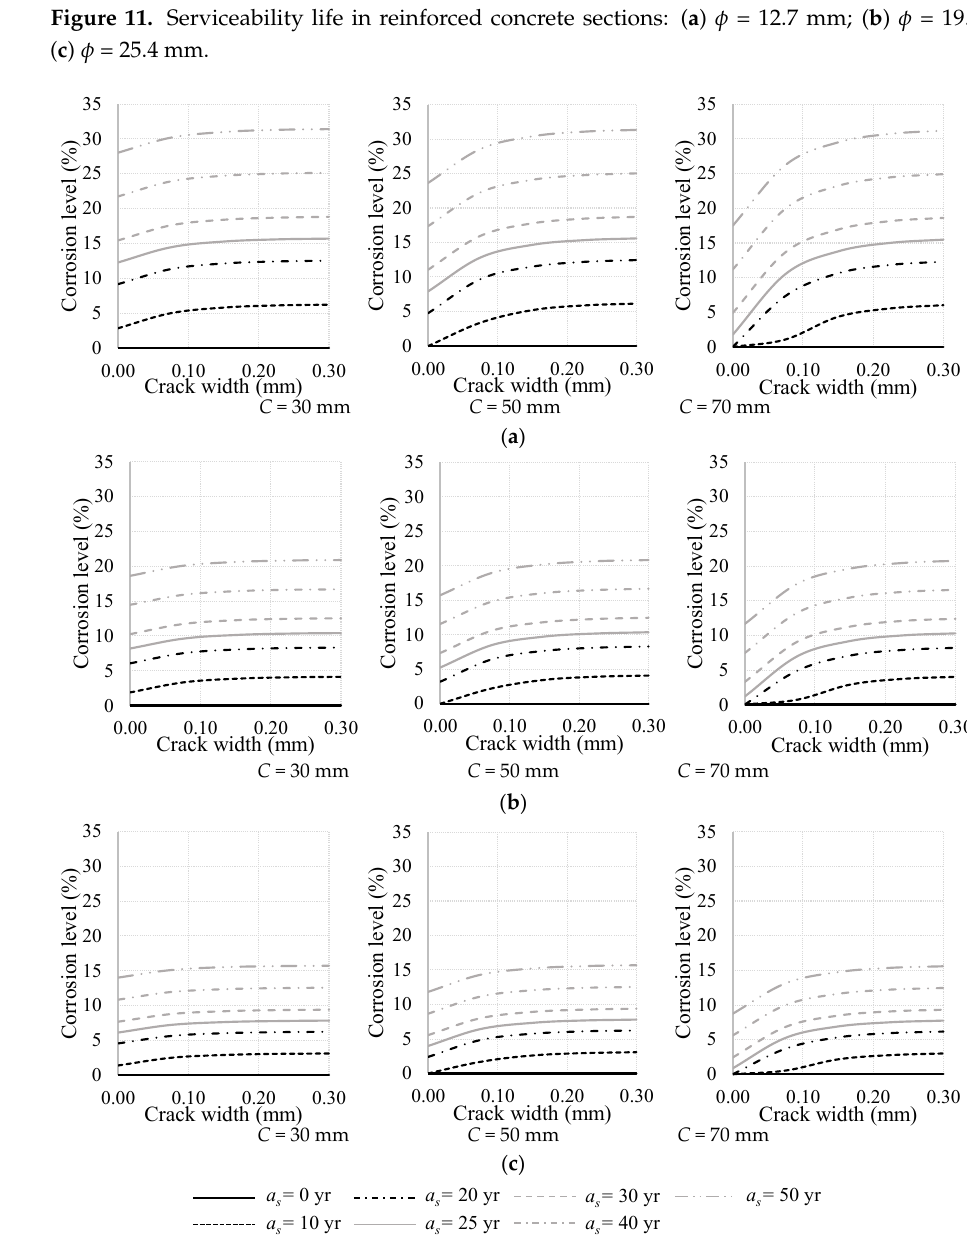
Figure 12. Corrosion level: ( a ) ϕ = 12.7 mm; ( b ) ϕ = 19.1 mm; ( c ) ϕ = 25.4 mm. The initiation time depends on the concrete cover. Regardless of the width cover, the initiation time is significantly reduced (up to 98%) because of the crack with effect, event within its recommended range. It is due to the initiation time which was significantly re ‐ duced (up to 98%) because of the cracked cover. As a result, the serviceability life can reduce up to 62% ( C = 7 cm).